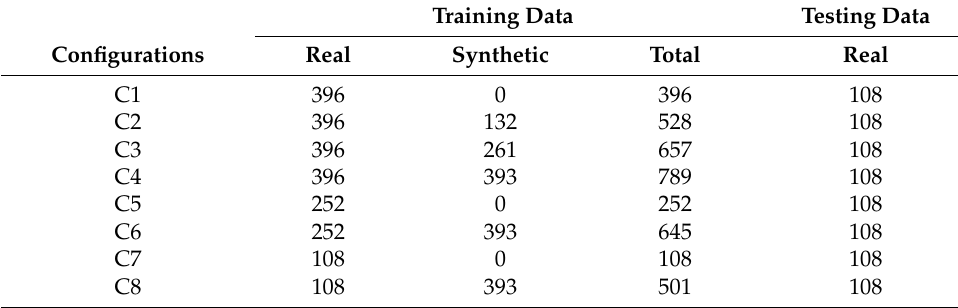
Table 3. Definition of the real/synthetic sample split in each configuration.